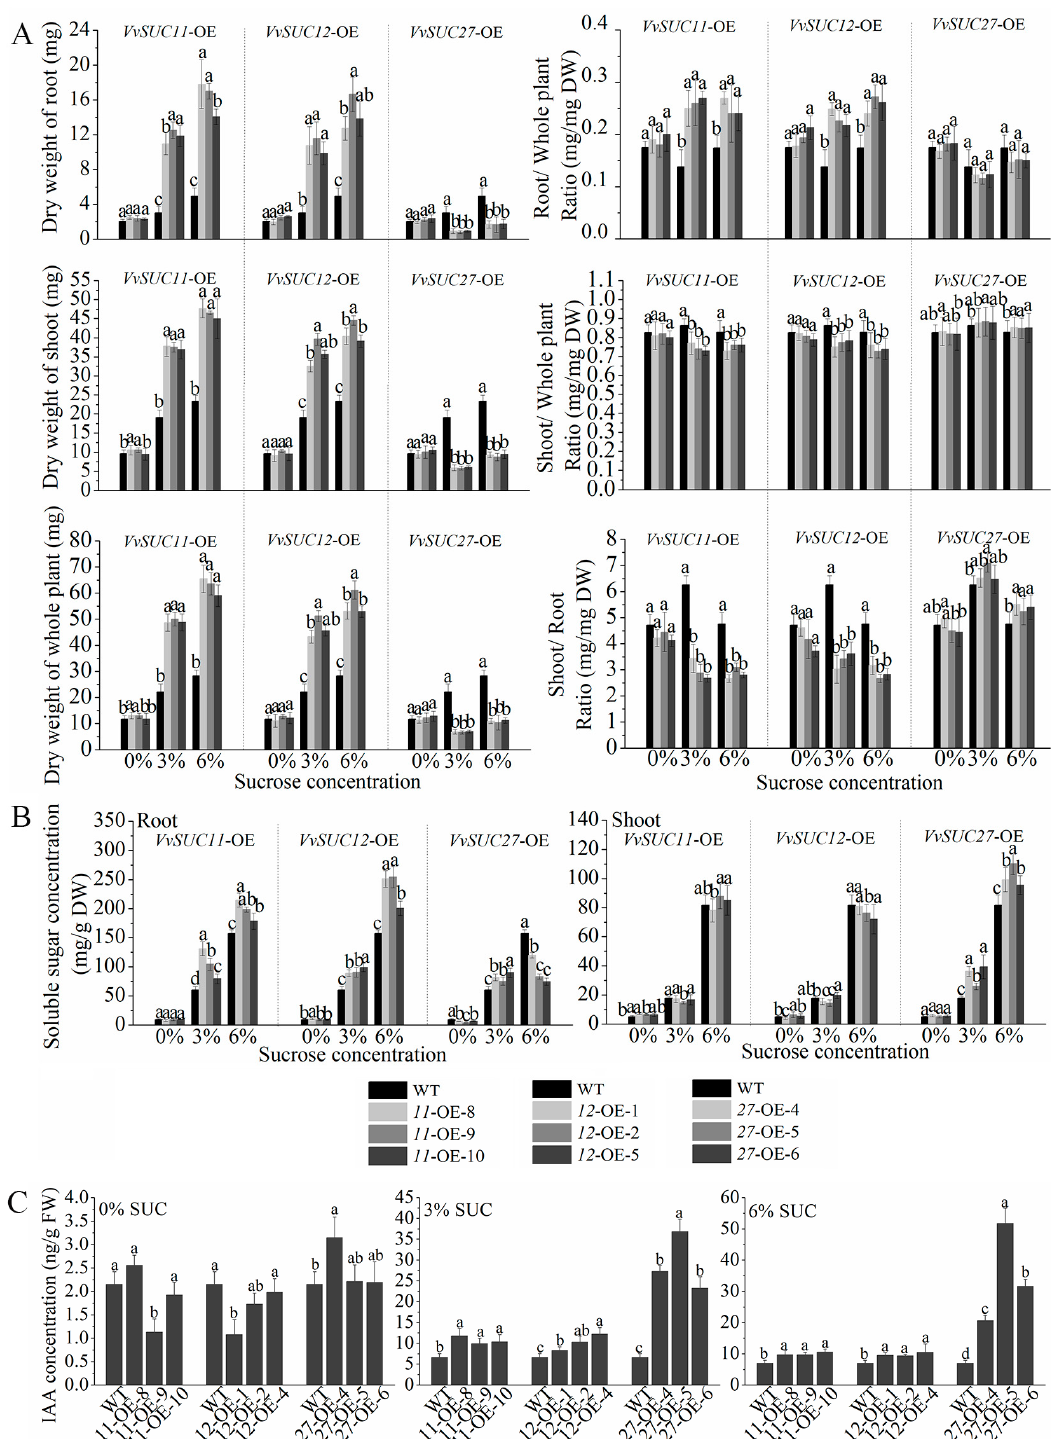
Figure 3. Dry weight, soluble sugar concentration, and endogenous plant auxin levels in 4-week-old VvSUC -OE Arabidopsis grown in media supplemented with di ff erent sucrose concentrations. ( A ) The dry weight of roots, shoots, and whole plants and the dry weight ratios for root / whole plant, shoot / whole plant, and shoot / root of VvSUC11 -, VvSUC12 -, and VvSUC27 -OE lines, respectively. DW = dry weight. ( B ) The soluble sugar concentrations in the roots and shoots of VvSUC -OE lines. ( C ) The indole-3-acetic acid (IAA) concentration in the seedlings of VvSUC -OE lines. FW = fresh weight. Data are expressed as mean ± SD (n = 3). Di ff erent letters indicate significant di ff erences ( P < 0.05) between each VvSUC -OE line and WT, as determined by ANOVA followed by Tukey’s